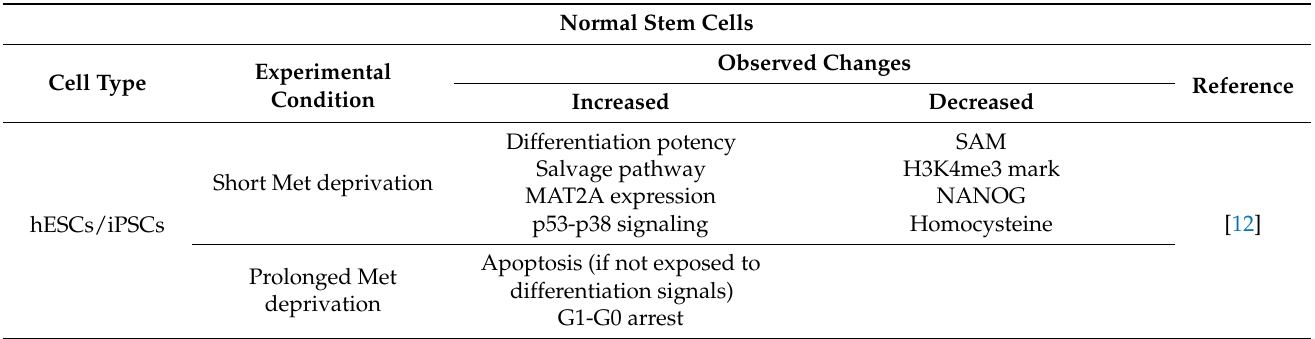
Table 1. Highlights of recent publications in relation to methionine restriction outcome